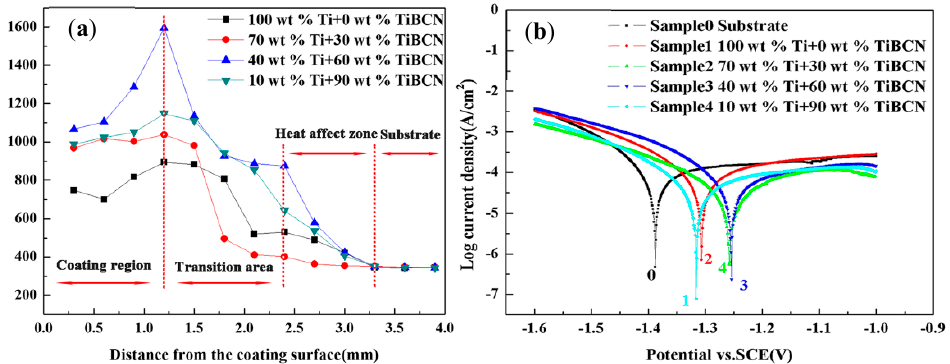
Figure 6. Microhardness and polarization curve of Ti/TiBCN composite coatings with the different TiBCN contents. ( a ) Microhardness, and ( b ) polarization curve.